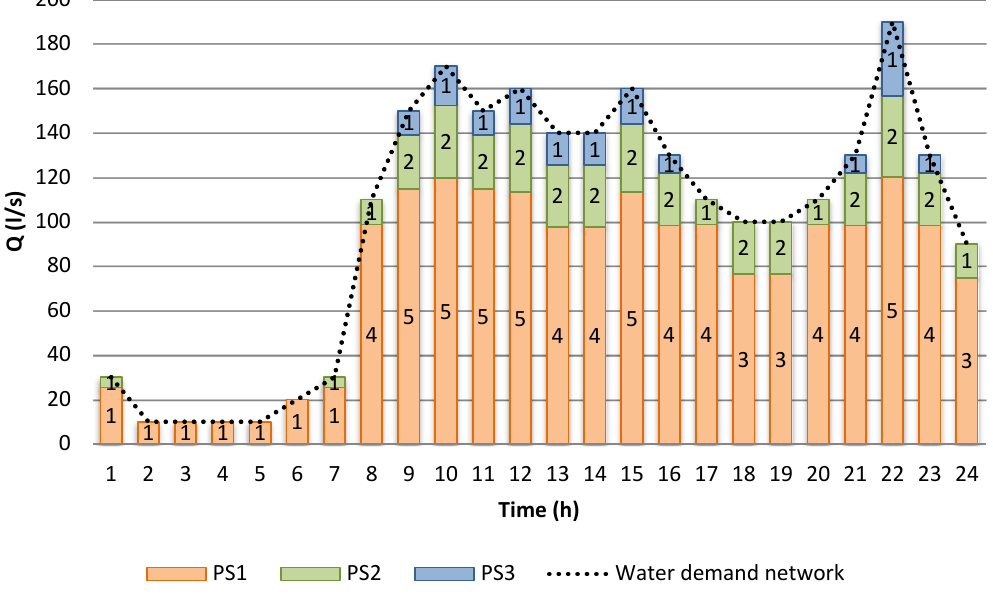
Figure 5. Optimized case study operations.